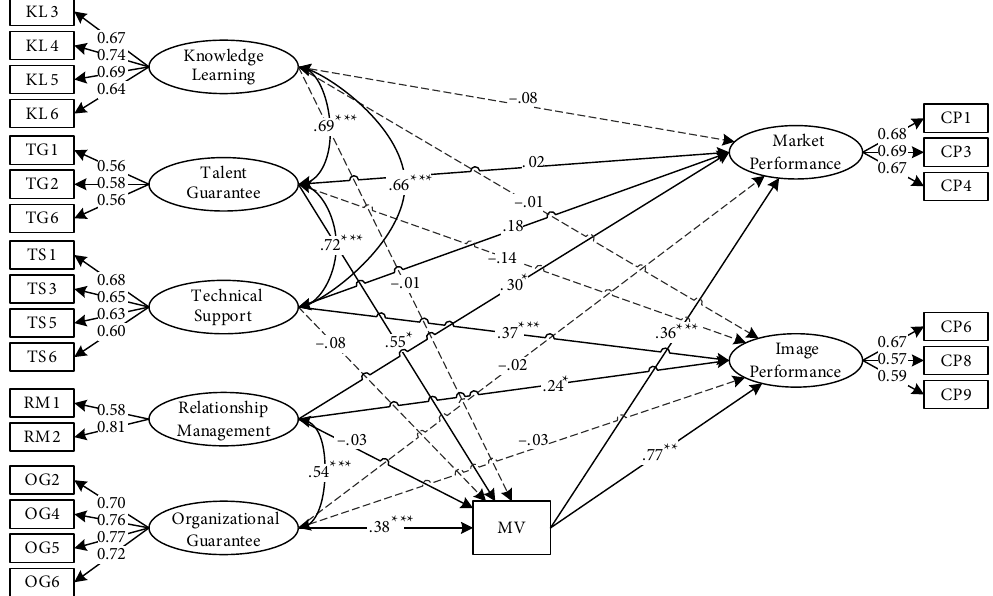
Figure 3. The final model with standardized regression